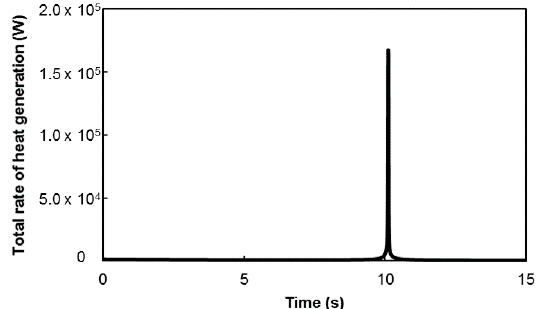
Figure 11. Rate of heat generation in the battery module.